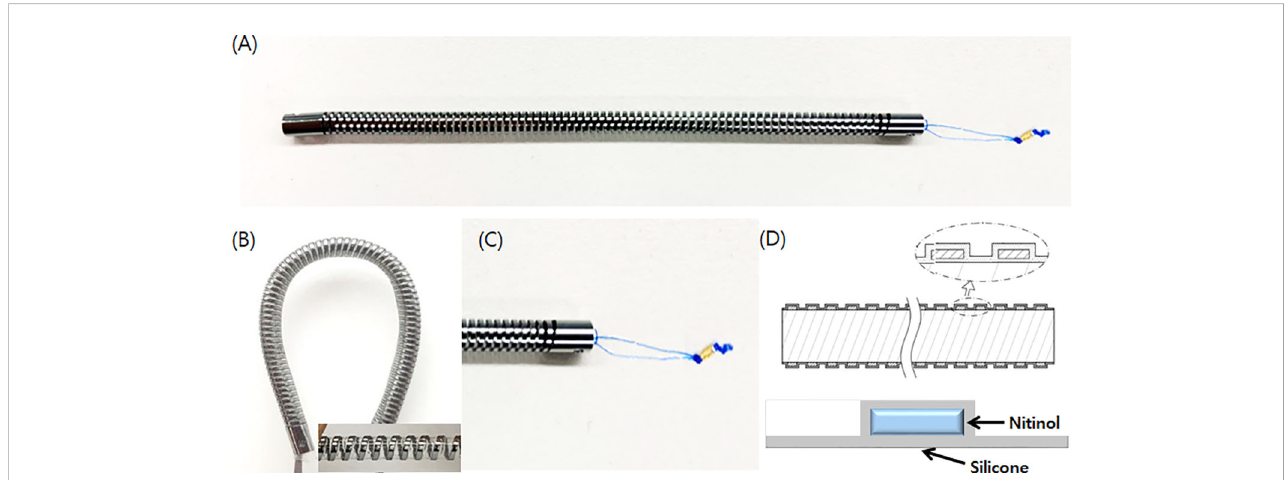
FIGURE 1 Novel biliary metal stent with coil-spring structure. (A) Structure of novel stent. (B) Coil-spring structure was adopted to increase fl exibility and prevent migration. (C) A silicone skirt was installed at the distal end to prevent duodenal mucosa damage and a lasso was attached for endoscopic removal. (D) Silicone coating was applied to both sides of the